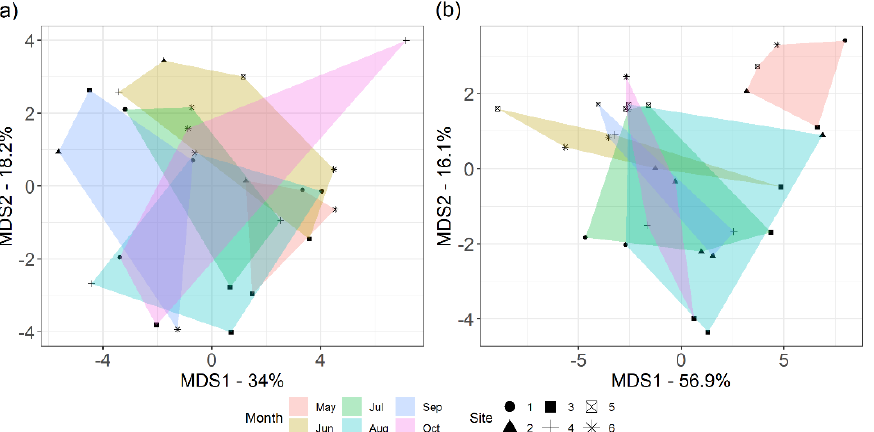
Figure 3. Multidimensional scaling (MDS) of N – cycle – related genes using Euclidean distance for 25 selected assays. ( a ) DNA copies; ( b ) transcript quantities.